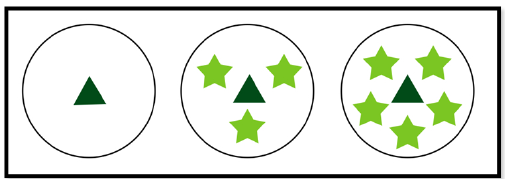
Figure 1. Experimental design of the control treatment, in high and low density of Polygonum ferrugineum to which Alternanthera philoxeroides was submitted. Each of these treatments had 12 replicates (half in high nutrient availability - H Nutrient; half in low nutrient availability - L Nutrient), totaling 36 experimental units. Alternanthera philoxeroides ( ▲ ); Polygonum ferrugineum ( ★